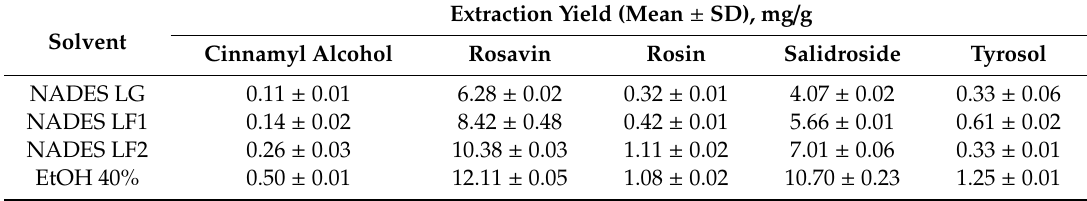
Table 1. Extraction yields of phenyletanes and phenylpropanoids from R. rosea by ultrasonic-assisted extractions (UAE) with natural deep eutectic solvent (NADES) and 40% aqueous ethanol.